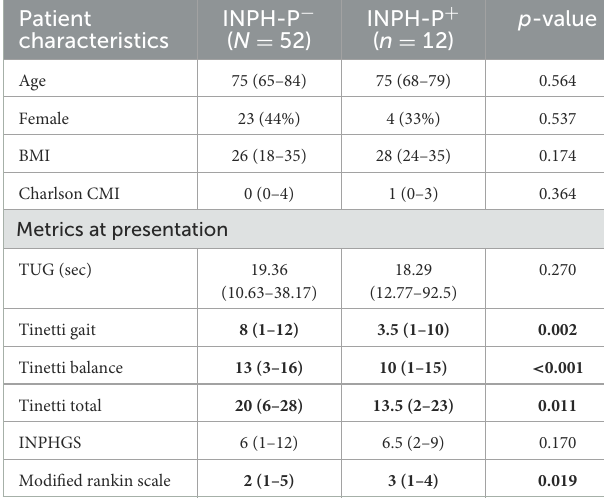
TABLE 1 Baseline characteristics of the 64 INPH patients comparing INPH patients with and without parkinsonism. Patient